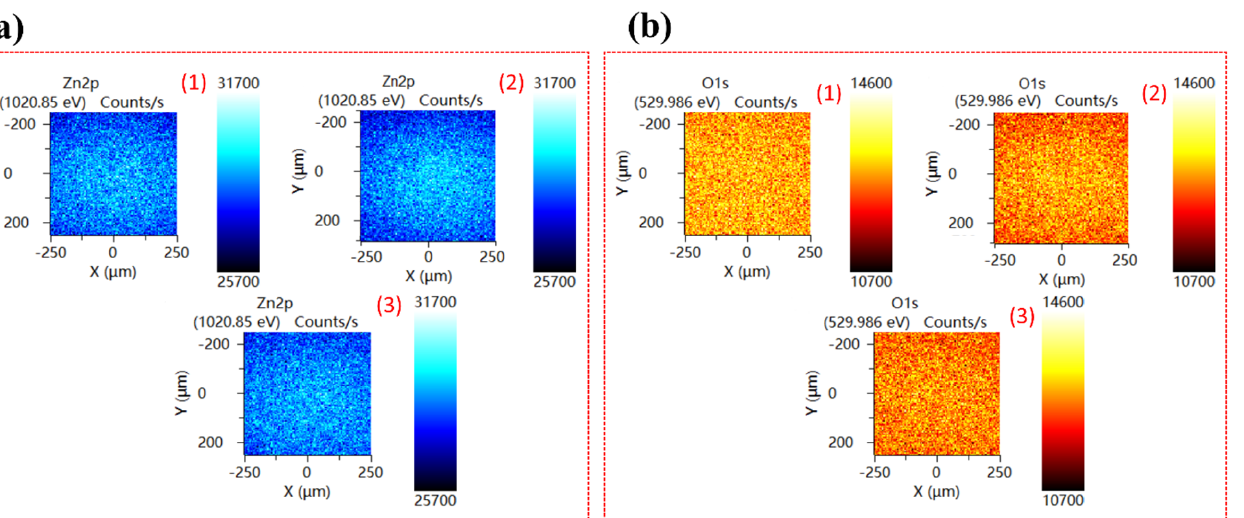
Figure 2. XPS core-level spectra of ( a ) Zn 2p and ( b ) O 1 s. The black dashed line indicates the peak position, and the horizontal double-head arrow represents the spin-orbit splitting ( Δ E = 23.08 eV). Deconvoluted features of the O 1 s peak for ( c ) <0001>, ( d ) <1010>, and ( e ) <1120> orientation. Black spheres represent the experimental values, and the continuous red line indicates fitted results using the Gaussian fitting function.